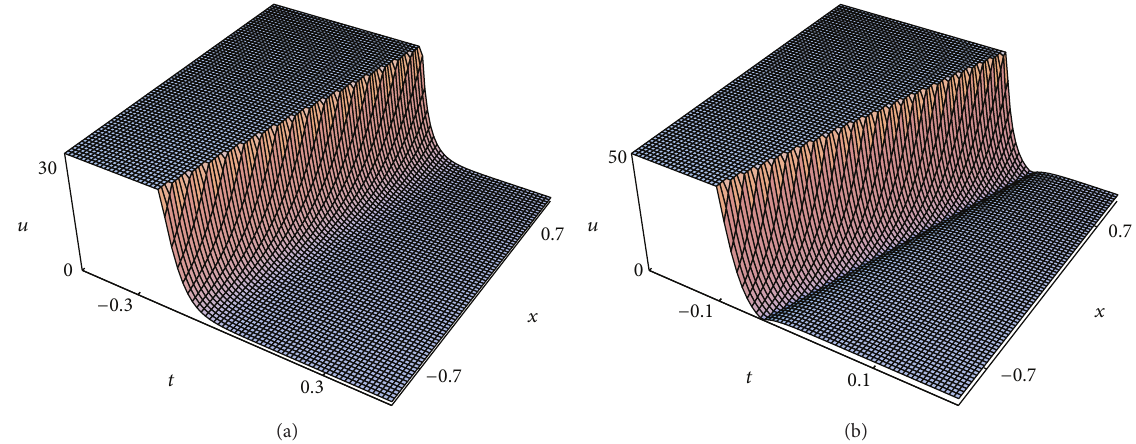
Figure 1: Evolution of the solutions of (25). (a) Shock soliton: parameters are 𝛼 = 0 , 𝛽 = 1 , 𝑎 1 = 1 , 𝑏 0 = 2 , and 𝑘 = 3 . (b) A shock soliton in collision with a dark soliton: parameters are 𝛼 = 0 , 𝛽 = 1 , 𝑎 1 = 3 , 𝑏 0 = −2 , and 𝑘 = 4